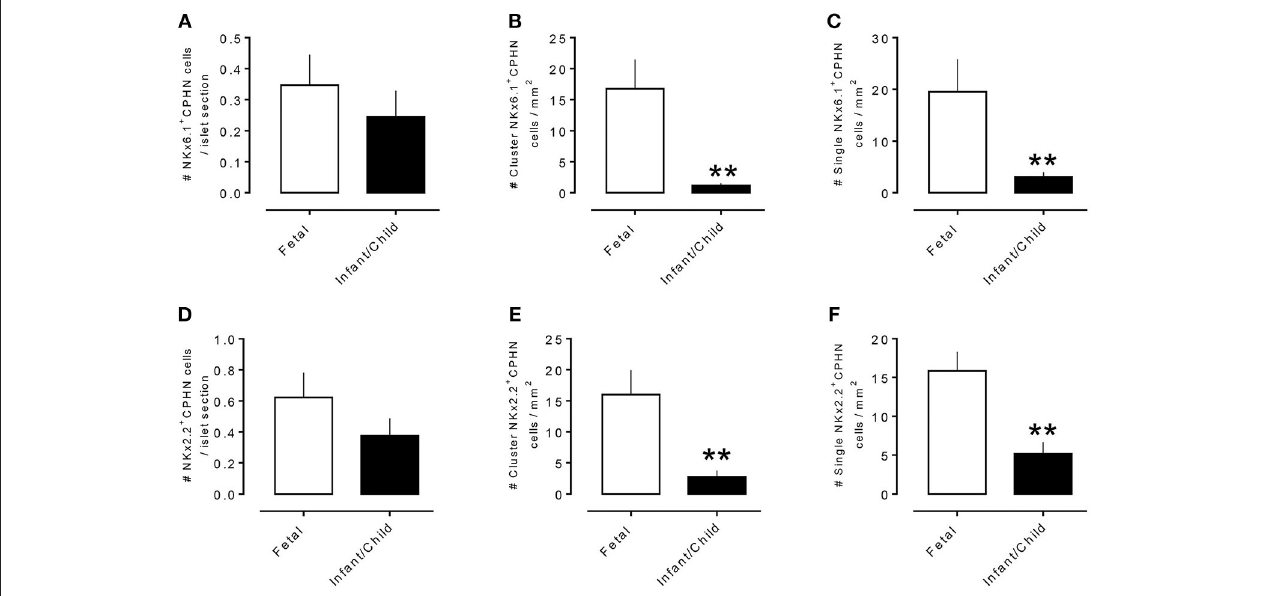
FIGURE 5 | Comparison of number of CPHN cells expressing transcription factors NKX6.1 and NKX2.2 in different compartments of fetal and infant/child pancreas. CPHN cells that express either NKX6.1 or NKX2.2 showed variability in their numbers among different compartments of the pancreas sections of both fetal and infant cases. The number of CPHN cells located within the islets that expressed either NKX6.1 (A) or NKX2.2 (D) was similar in fetal and infant/child cases but NKX6.1 + and NKX2.2 + CPHN cells found as clusters (B,E) or single cells (C,F) were significantly higher in fetal cases compared to infant/child cases. ** p < 0.01, n = 7 for fetal cases and n = 10 for infant/child